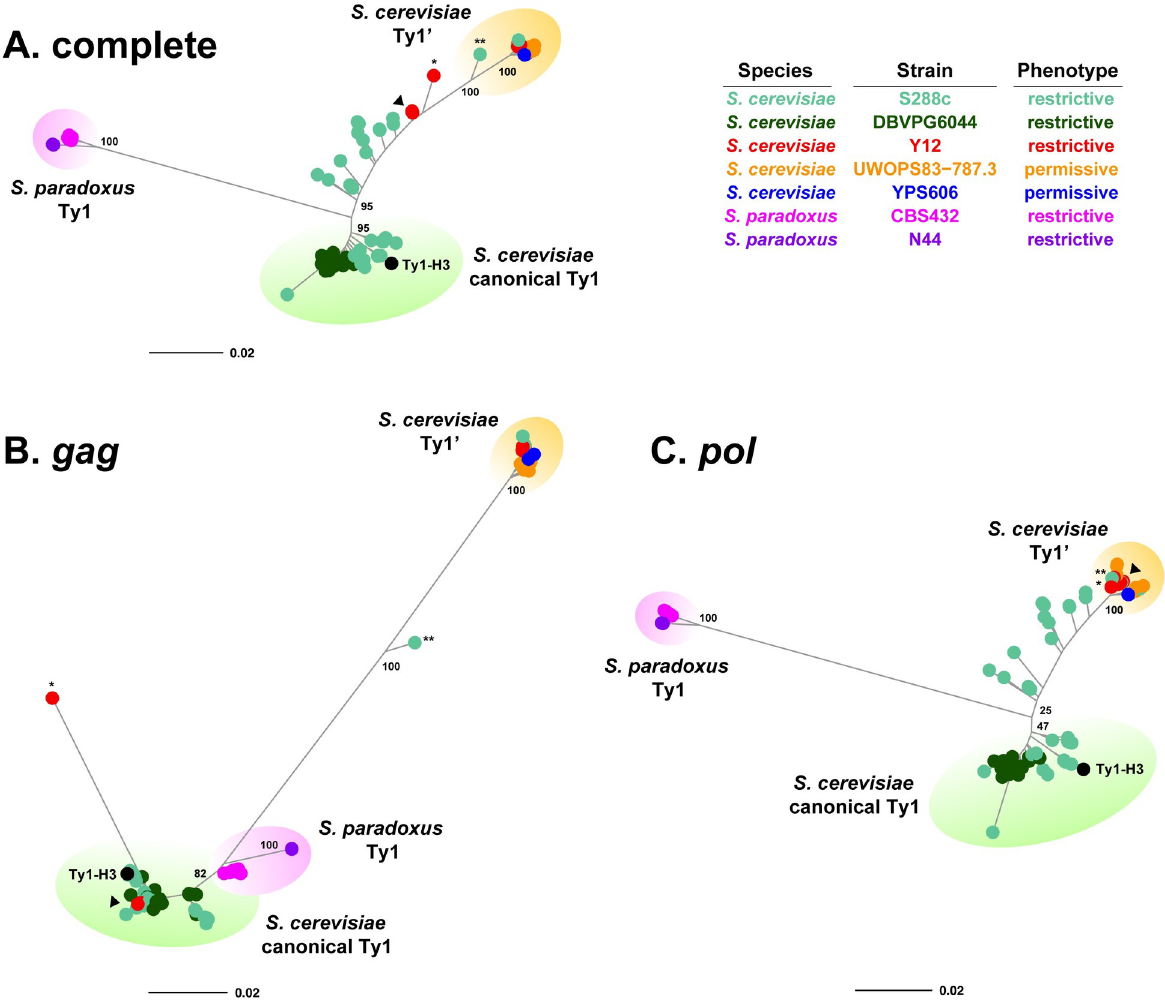
Fig 2. Clustering of sequences from full-length Ty1 elements in Saccharomyces strains with Ty1-H3 mobility phenotypes. Unrooted consensus trees for full-length elements based on ( A ) complete Ty1 sequences, ( B ) the Ty1 gag gene region only, and ( C ) the Ty1 pol gene region only. Trees were constructed using the BioNJ clustering algorithm. Numbers at key nodes represent bootstrap support based on 100 replicates. The scale bar for branch lengths is in units of substitutions per site. The Ty1-H3 tester element used in mobility assays is shown in black. Recombinant elements between Ty1’ and canonical Ty1 within gag are starred ( � Y12_f109; �� : S288c_f486). Seven closely related “mosaic” Y12 elements that are recombinants between canonical Ty1 and Ty1’ are labeled with an arrowhead. We note that in some cases filled circles can represent multiple identical or nearly identical sequences (e.g. seven closely related Y12 elements,